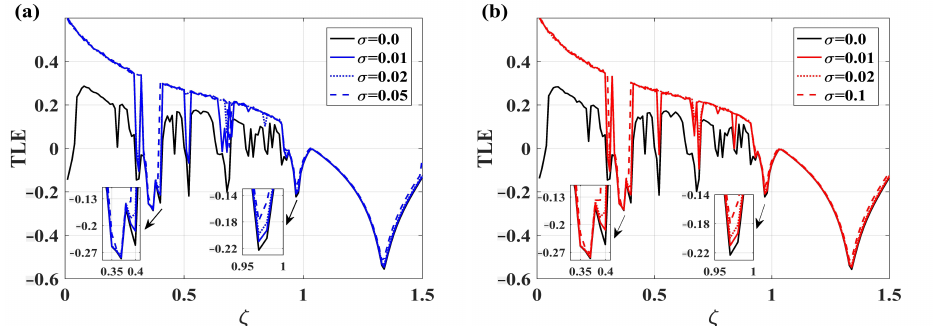
Figure 8. The TLE with the variation of damping coefficient ζ under different intensities; ( a ) is obtained under the initial condition IC-1; ( b ) is obtained under the initial condition IC-2.